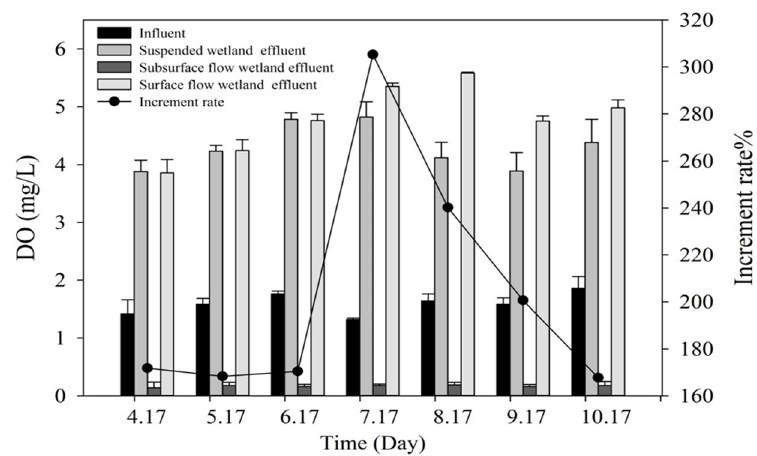
Figure 4. DO concentration of the inflow and the increase rate.